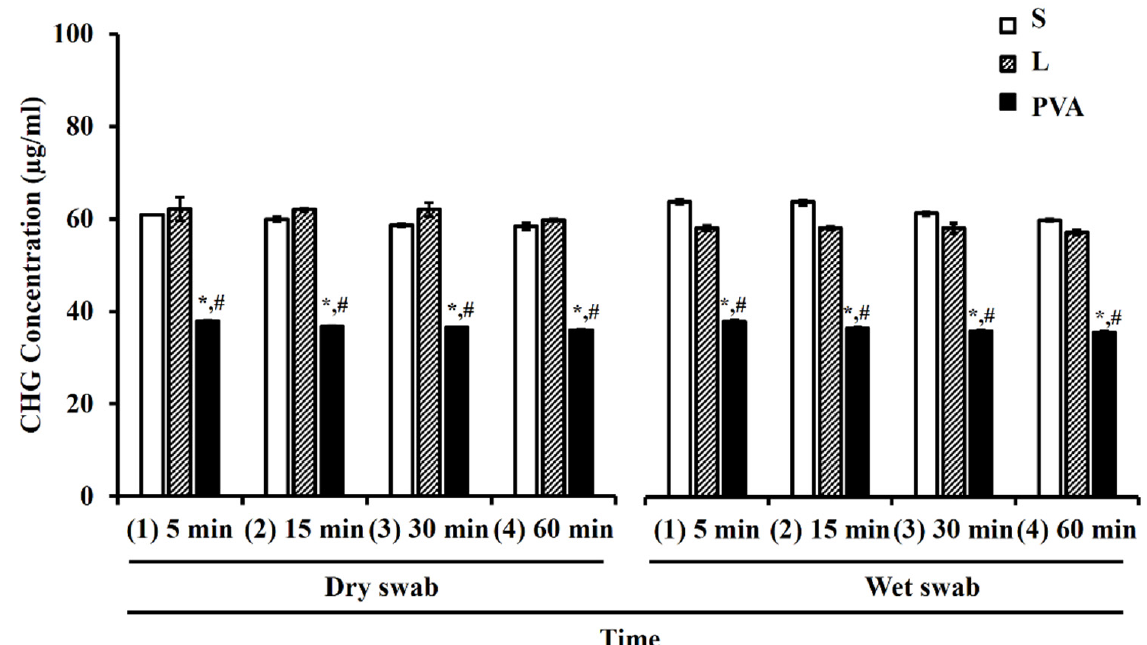
Figure 4. The concentration of the CHG loss from the skin of the healthy volunteers depended on the number of dry or wet swabs after spraying the CHG-FFS. The experiment was repeated three times, and the results were presented as the mean ± SD. * and # statistically significant ( p < 0.05) with S and L, respectively.